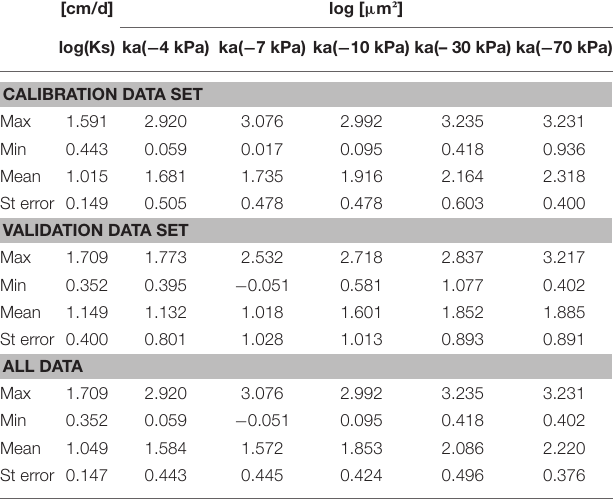
TABLE 2 | Logarithmic saturated hydraulic conductivities (Ks, cm/day) and air permeability (ka, µ m ² ) measured after applying a draining pressure of − 4, − 7, − 10, − 30, and − 70 kPa for the calibration and validation data sets [minimum values (Min), maximum values (Max), mean values (Mean), and standard deviation (St